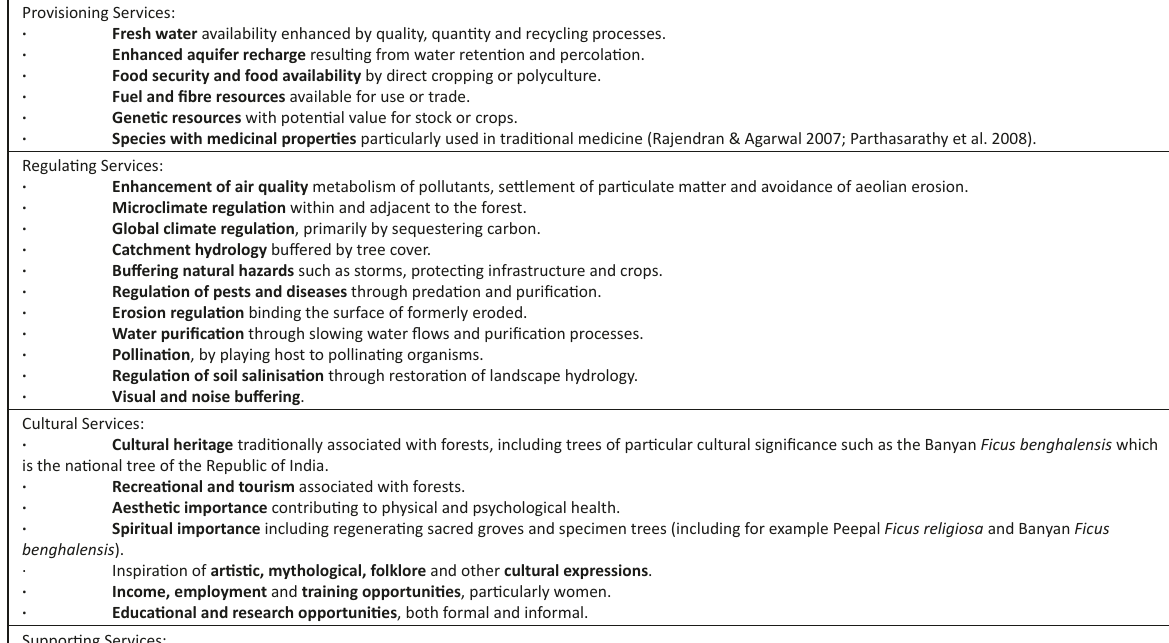
Table 2. Ecosystem service benefits likely to arise from TDEF restoration (after Everard 2017) Provisioning Services: